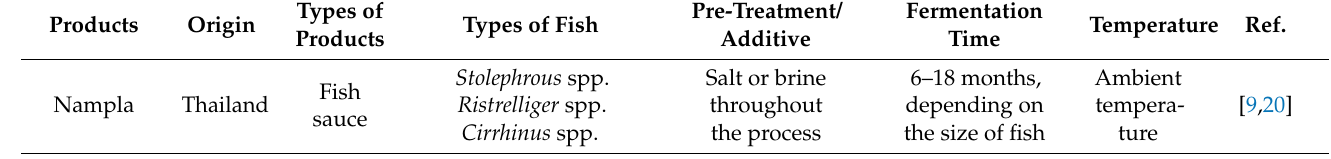
Table 1. Summary of various fermented fish products and their fermentation